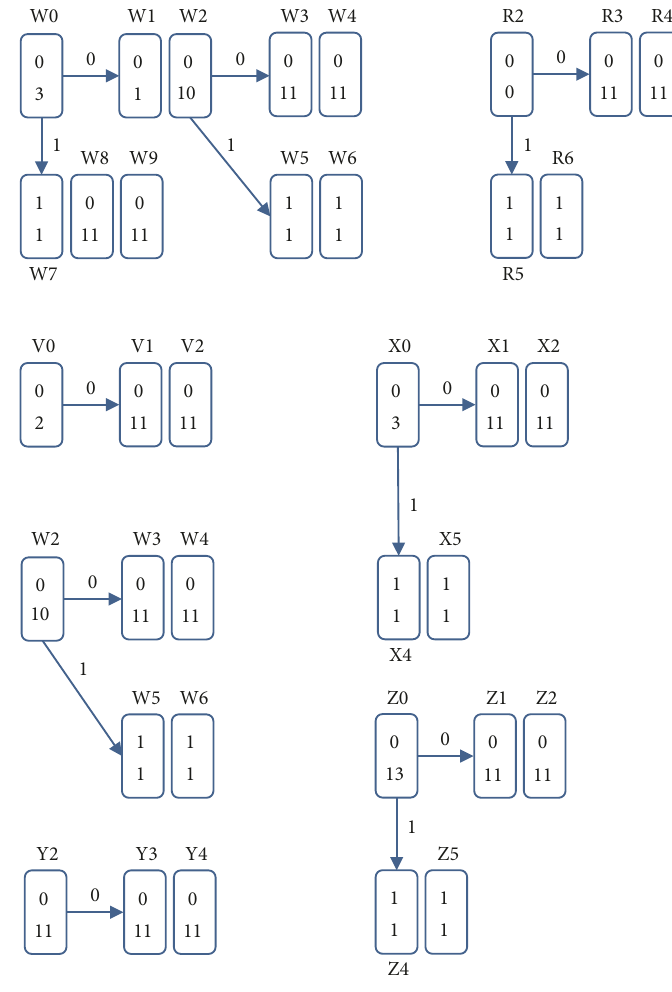
Figure 4: Iteration of time period